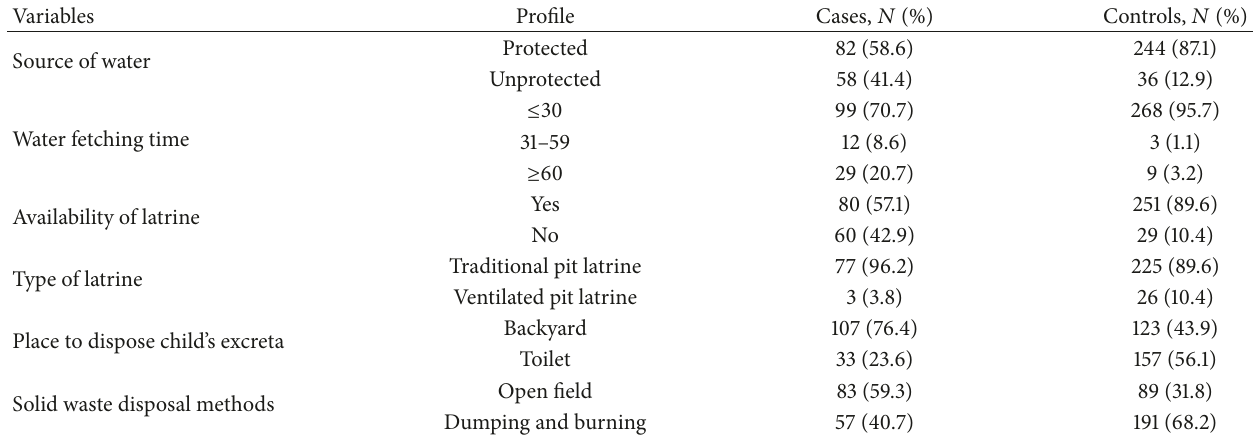
Table 4: Environmental health and sanitation practice of cases and controls from Dubti District, Afar Regional State, Northeast Ethiopia, January 2014 (cases: 𝑁 = 140 and controls: 𝑁 = 280